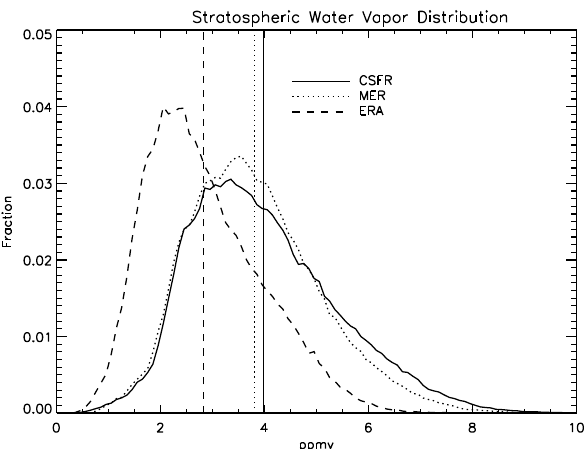
Fig. 4. PDF of water vapor concentration for parcels in the strato- sphere. The PDF distribution is normalized by the total number of stratospheric parcels, bin size is 0.1ppmv. The vertical lines in- dicate the mean value. ERAi is systematically drier and noted in S2012. Solid lines, CFSR; dotted lines, MERRA, and the dashed line ERAi (labeled ERA in